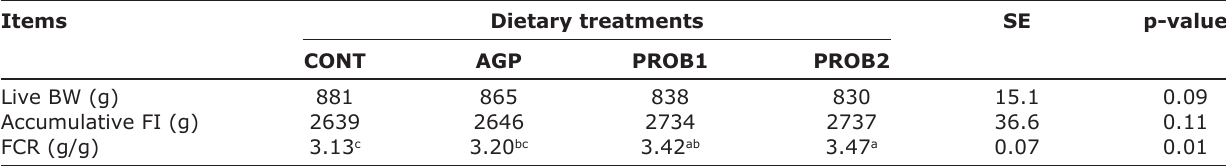
Table-2: Effect of multi-strain probiotic preparation in combination with vitamins and minerals on performances of the Indonesian indigenous crossbred chickens at 10 weeks of age. Items Dietary treatments